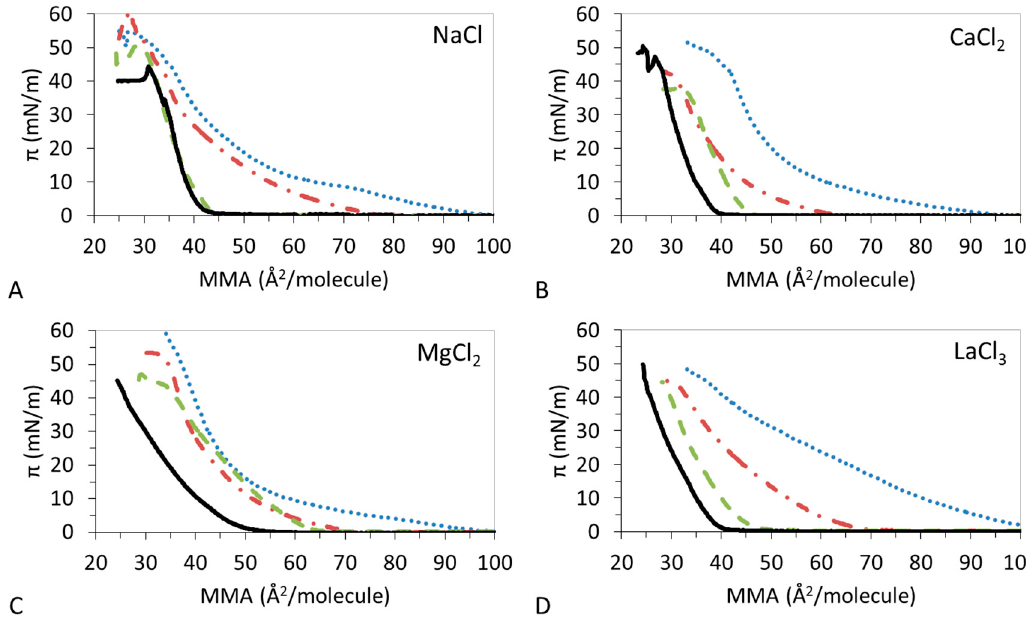
Figure 1. Surface pressure-area ( π -A) isotherms for DPPC:DPPS:CHOL spread onto solutions I = 15 mM ( A ) NaCl ( B ) CaCl 2 ( C ) MgCl 2 ( D ) LaCl 3 . DPPC:DPPS (blue dotted line), DPPC:DPPS:CHOL-30 (red dash-dotted line), DPPC:DPPS:CHOL-70 (green dashed line), CHOL (black straight line). Mean values of three experiments with standard deviation <5%. T = 23 °C, lipid composition is described in